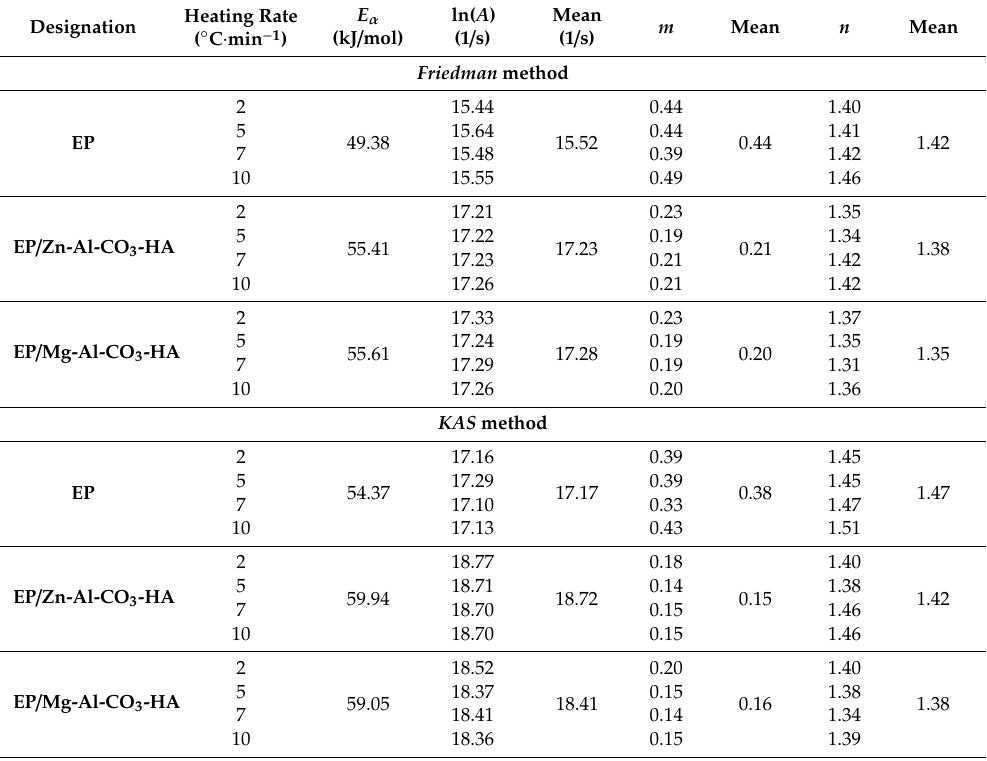
Table 4. The kinetic parameters of neat epoxy and its nanocomposites based on the Friedman and KAS methods.